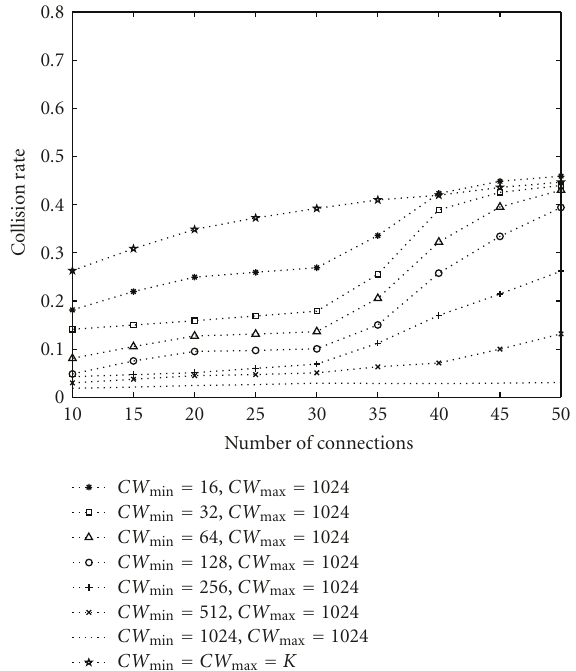
Figure 5: Collision rate as a function of start contention window size and tra ffi c load.